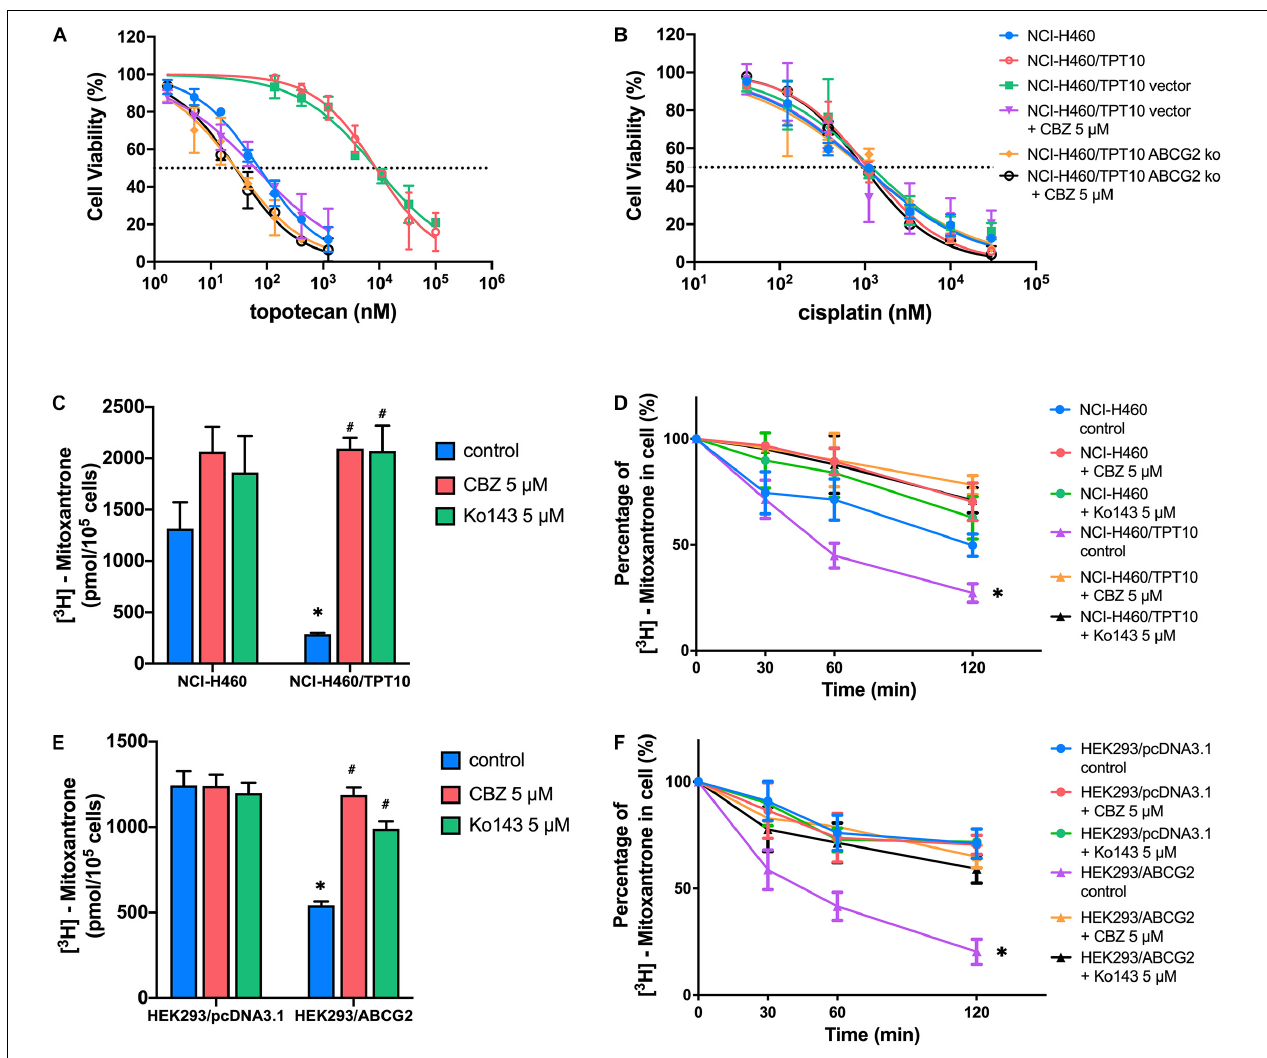
FIGURE 2 | ABCG2 inhibition as a major mechanism for the reversal activity of cabozantinib. (A,B) Cell viability was determined by MTT assay and displayed the changes in response to different concentrations of topotecan (A) or cisplatin (B) with the presence of 5 µ M cabozantinib in NCI-H460, NCI-H460/TPT10, the ABCG2 gene knockout subline of NCI-H460/TPT10, and the vector-transfected cells. Data points with error bars represented the mean viability (%) ± SD of at least three independent experiments, each done in triplicate. (C,E) The effect of cabozantinib on the cellular accumulation of [ 3 H]-mitoxantrone in H460, H460/TPT10, HEK293/pcDNA3.1, and HEK293/ABCG2 cells. ∗ indicates p < 0.05 comparing resistant cell line to parental cell line with the same treatment; # indicates p < 0.05 comparing a group with cabozantinib to the corresponding cell line group without ABCG2 inhibitor. Ko143 was used as a positive control of ABCG2 inhibition.